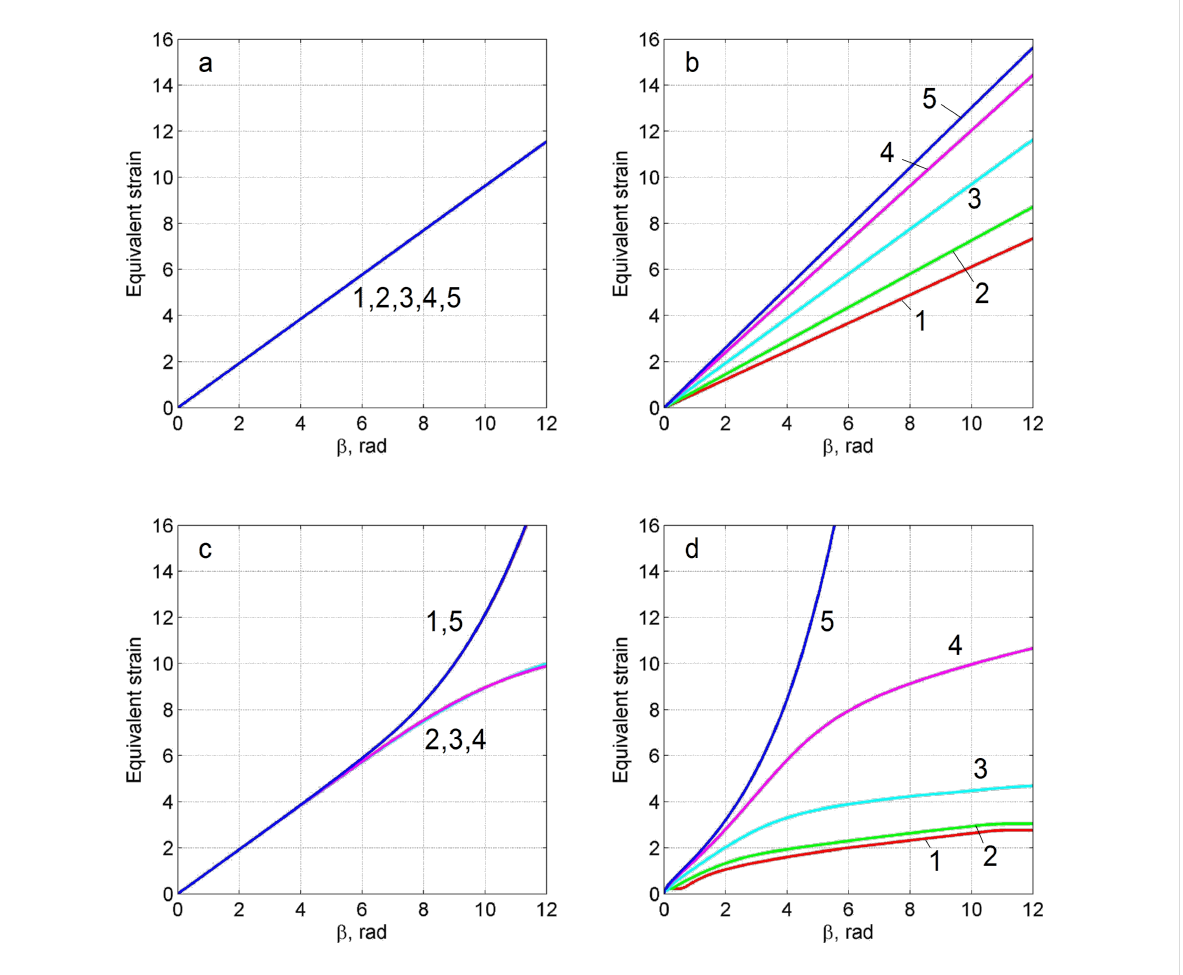
Figure 4: Dependence of the von Mises strain on β in points 1–5 shown in Figure 1. The indices a, b, c and d correspond to the simulation conditions shown in Table 1.